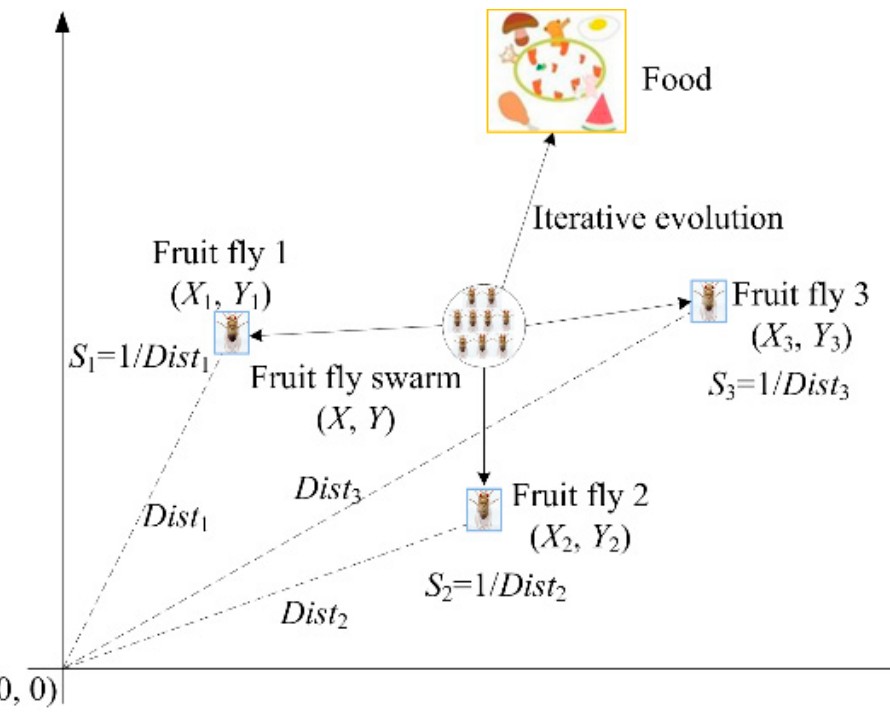
Figure 1. Food searching iterative process of fruit fly swarm.